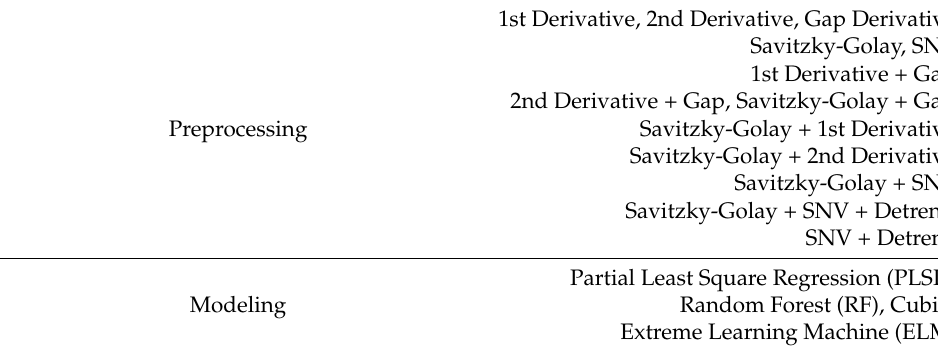
List of 13 preprocessing algorithms that were tested in combination with the 4 modelling